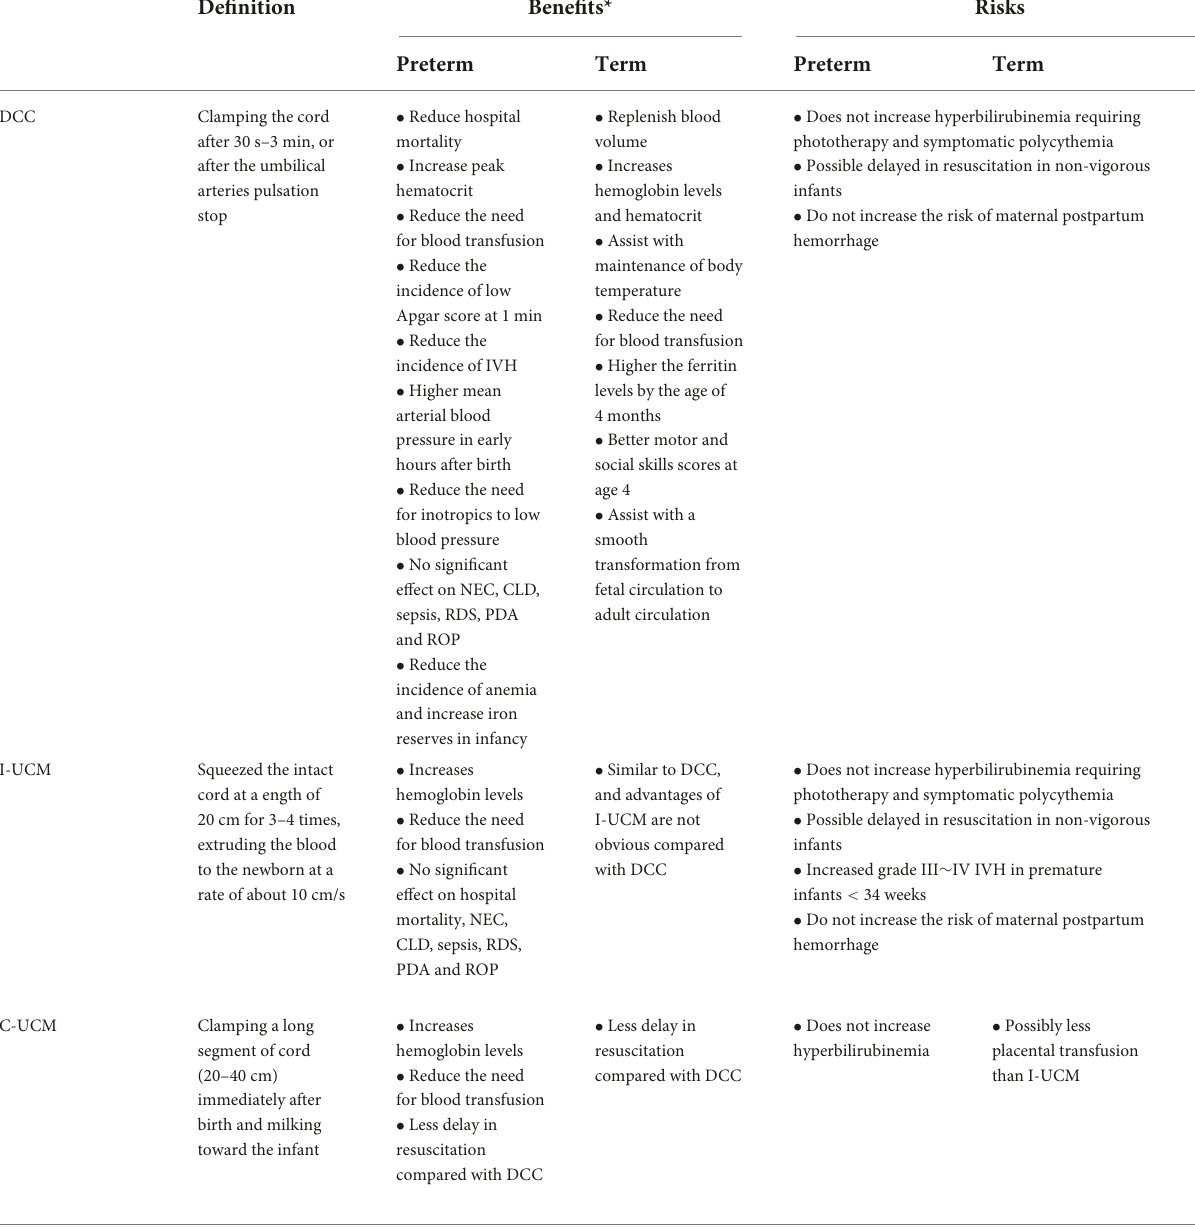
TABLE 2 Summary of three strategies for placental